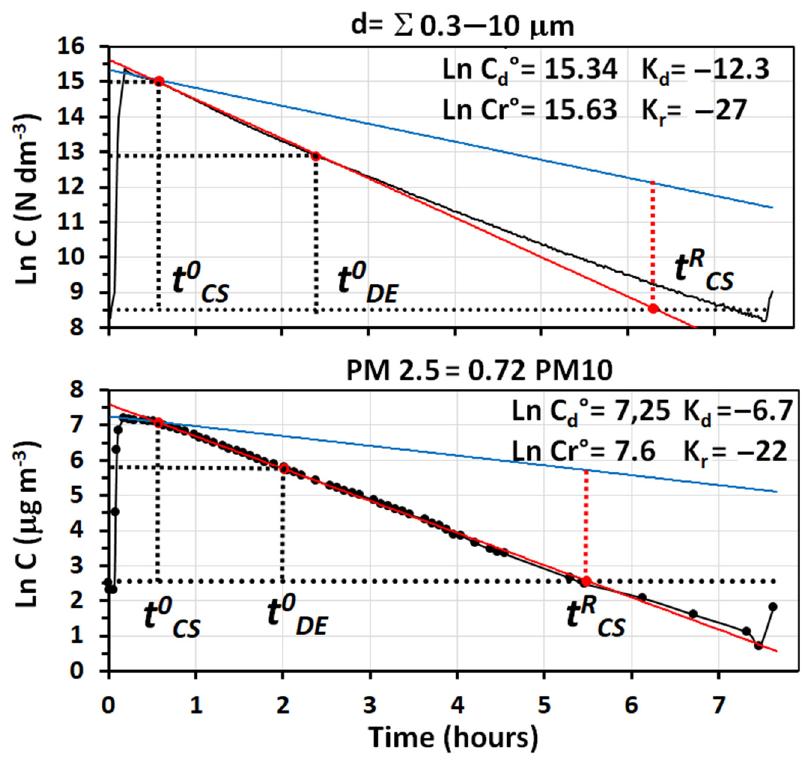
Figure 12. Semi-logarithmic plots of total particle number concentration and PM 2.5 recorded in the same experiments as Figure 11. The meaning of the symbols and lines is also the same as in Figure 11.